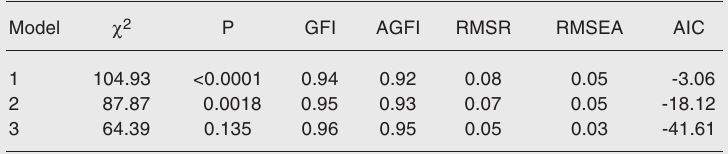
Table 3. Fit indices of three models tested on the second half of the sample (N = 316).